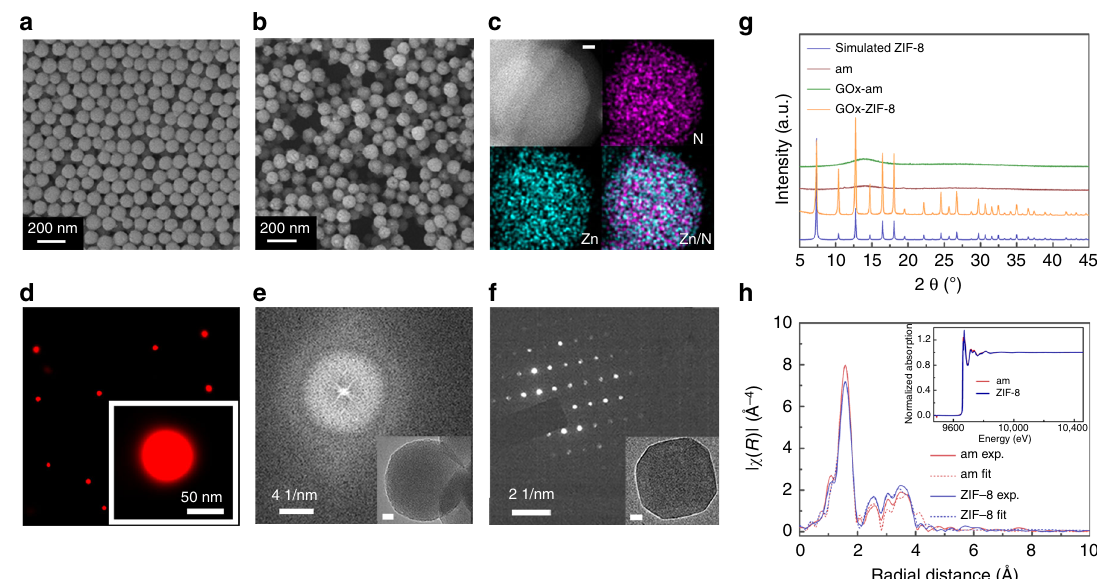
Fig. 1 Structural characterizations of enzyme-incorporated composites. Scanning electron microscopy (SEM) images of nanocomposites without ( a ) and with ( b ) GOx enzyme. c High-angle annular dark fi eld scanning transmission electron microscopy (HAADF-STEM) image of the GOx-incorporated nanocomposite and energy-dispersive spectrum (EDS) analysis, showing the distribution of Zn and N. Scale bar is 10 nm. d Stochastic optical reconstruction microscopy (STORM) image of GOx-incorporated nanocomposites. GOx is labeled with switchable fl uorescent dye, Cy5. Inset is a high- resolution image showing the distribution of GOx-Cy5 in a single nanocomposite. e , f Transmission electron microscopy (TEM) image and selected area electron diffraction (SAED) patterns of GOx-incorporated amorphous nanocomposite ( e , scale bar in inset is 10 nm) and GOx-incorporated ZIF-8 ( f , scale bar in inset is 20 nm). g X-ray diffraction (XRD) patterns of simulated ZIF-8, amorphous nanocomposite (am), GOx-incorporated amorphous nanocomposite (GOx-am), GOx-incorporated ZIF-8 (GOx-ZIF-8). h Pseudoradial distribution functions for ZIF-8, amorphous ZIF from experiment and corresponding fi tting data. Data were extracted through Fourier transformation of the X-ray adsorption spectra (inset) obtained at the K edge of zinc. Source data are provided as a Source Data fi